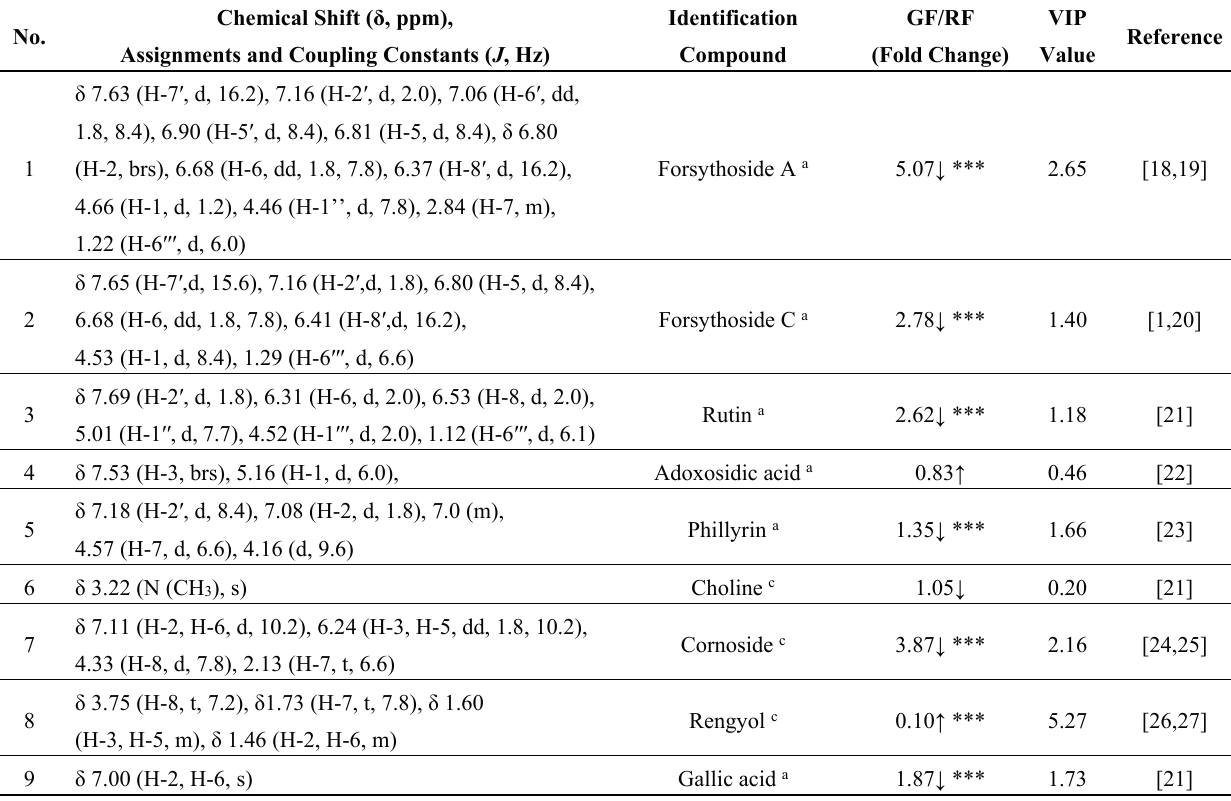
Table 1. Relative levels of metabolites detected by NMR in green Forsythiae Fructus (FF) (GF) and ripe FF (RF) (mean ± SD, n = 10). VIP, variable influence on